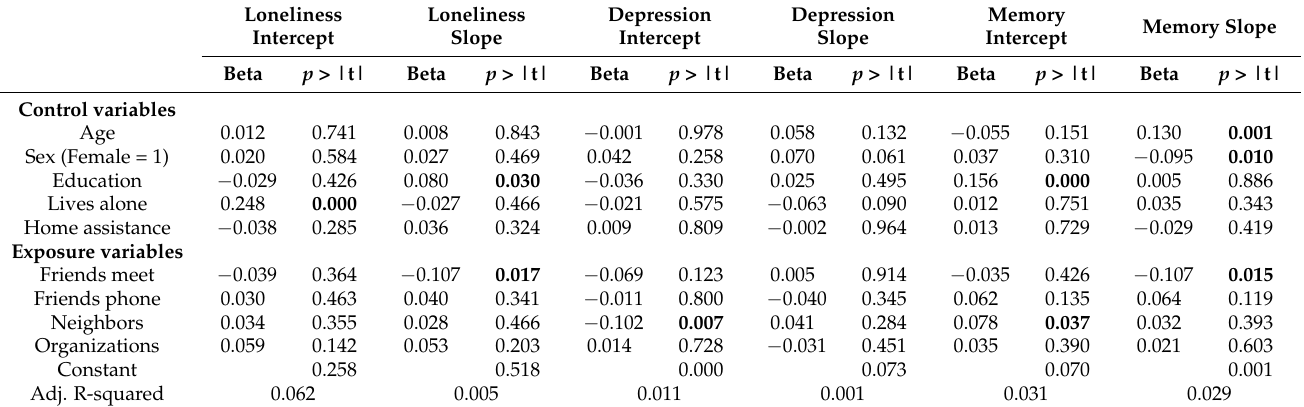
Table 4. Regression analysis on outcome variables among individuals in Profile 2 (average outcomes). n =